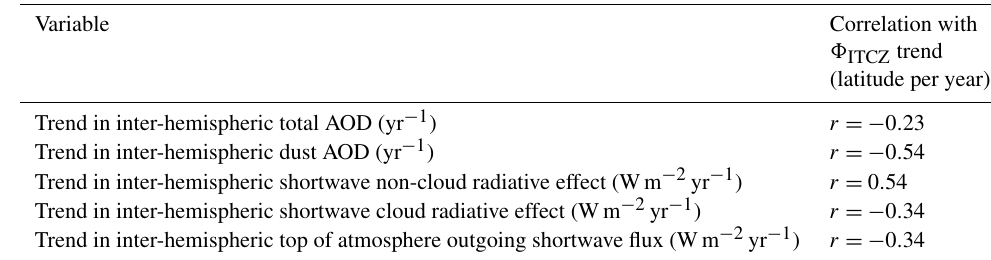
(cid:56) ITCZ trend (latitude per year)